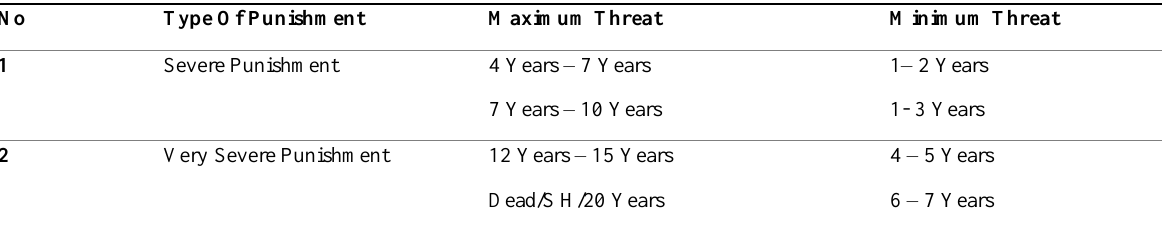
Table 1: Type of Punishment and Threats